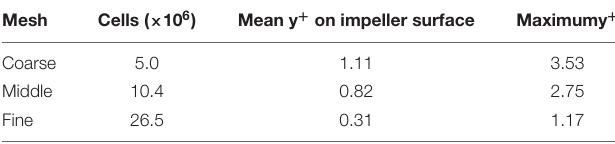
TABLE 3 | Details of mesh for grid sensitivity analysis.